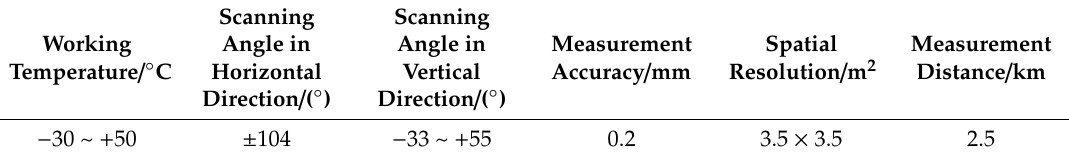
Figure 7. Monitoring area of radar system. Table 1. Main parameters of MSR-300 radar system.